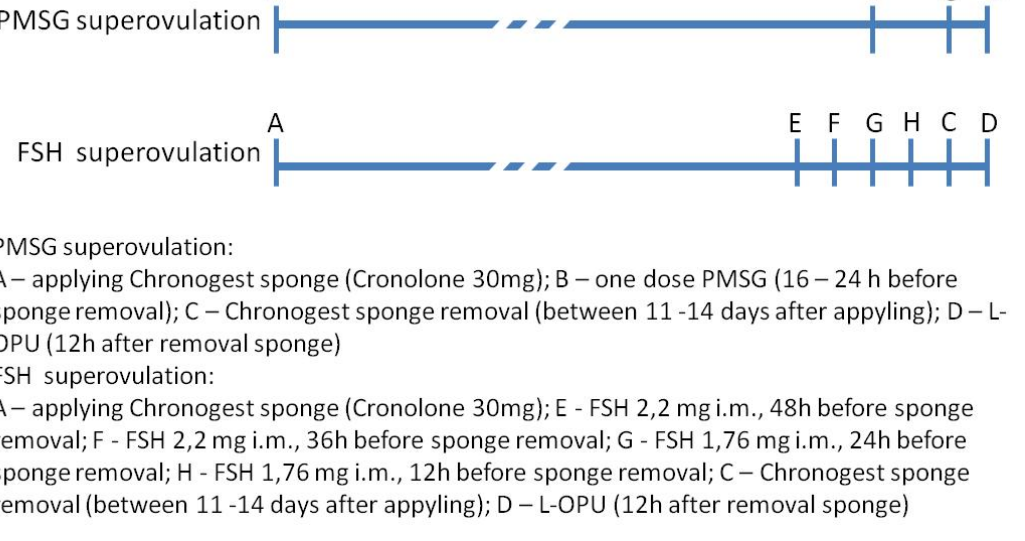
Figure 1. Schedule of estrus synchronization with Cronolone and superovulation with pregnant mare serum gonadotropin (PMSG) or follicle-stimulating hormone (FSH) treatment. serum gonadotropin (PMSG) or follicle-stimulating hormone (FSH)